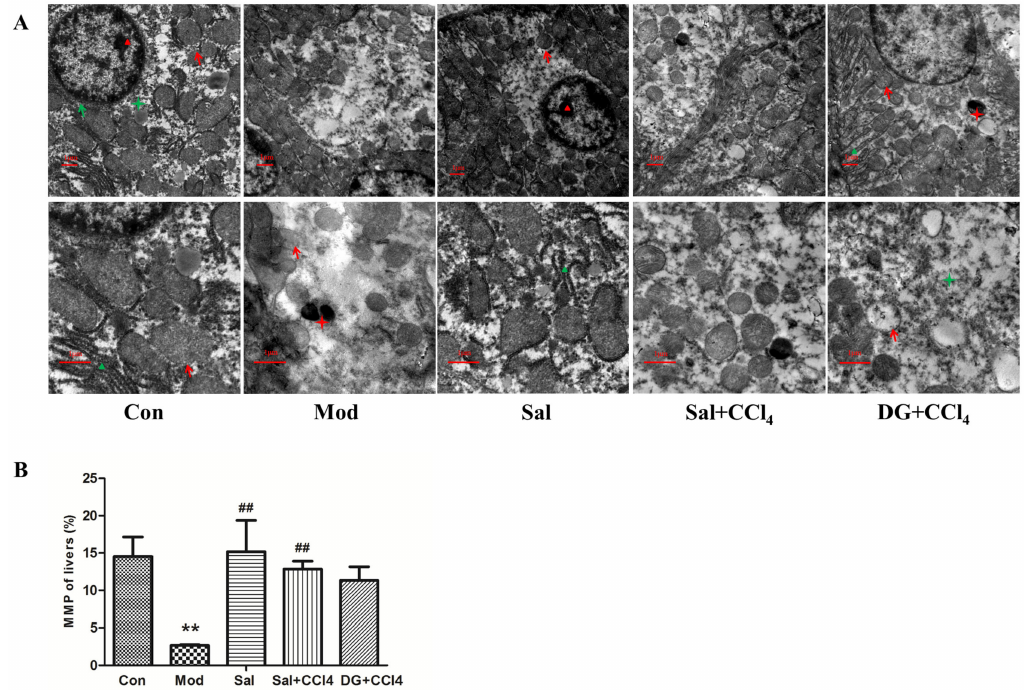
Figure 4. Salidroside protected liver ultrastructure, especially mitochondria in mice. ( A ) Conditions of liver ultrastructure in di ff erent groups: model mice induced by CCl 4 and mice treated with single salidroside, salidroside + CCl 4 , and diammonium glycyrrhizinate + CCl 4 (Con, Mod, Sal, Sal + CCl 4 , and DG + CCl 4 , respectively). In the Mod group, CCl 4 induced ultrastructural damage with decreased chromatinandorganelles, partlydissolvedridgesandmembraneofswollenmitochondria, andincreased secondary lysosomes. Salidroside and DG can remarkably alleviate ultrastructural